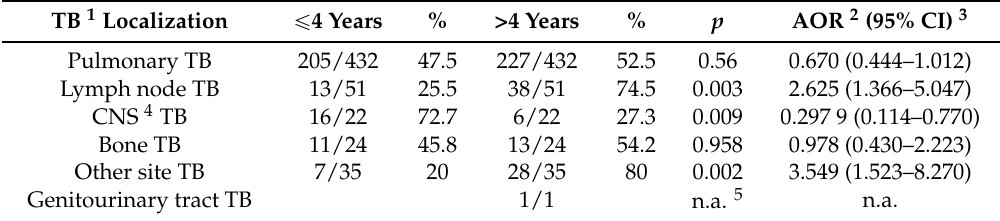
Table 3. Distribution of TB localization by age groups.